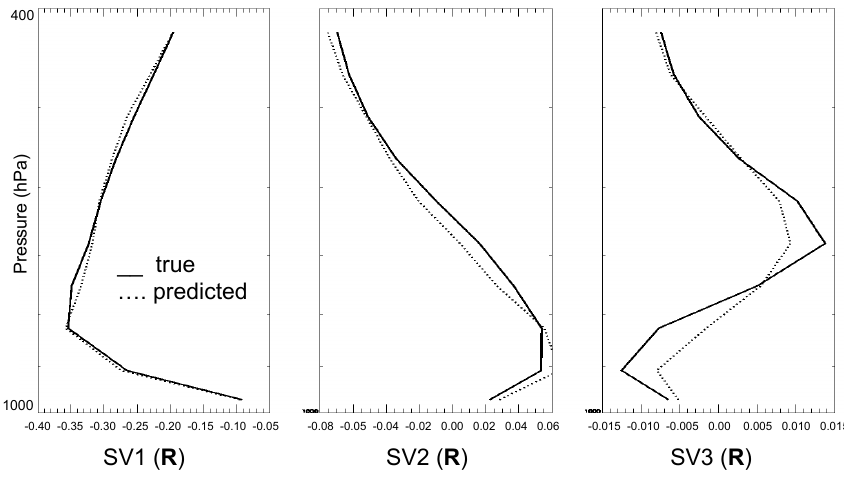
Fig. 11. Same as Fig. 9 but for TES-OMI test case and prediction. Figure 11. Same as Fig. 9 but for TES-OMI test case and prediction.